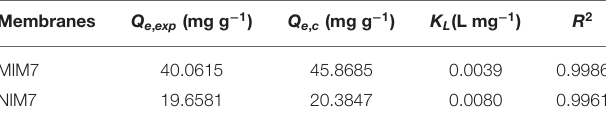
TABLE 2 | Langmuir adsorption isotherm constants for ACT onto the MIM7 and NIM7. Membranes